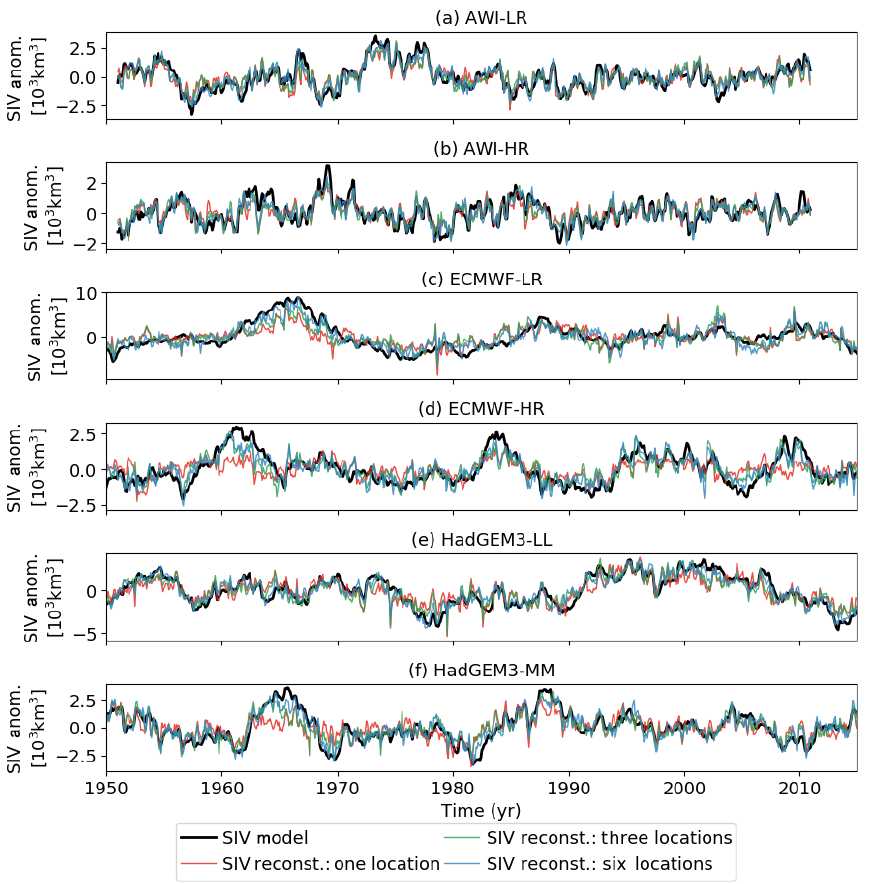
Figure 10. Lag-0 comparison between the original (black) and statistically reconstructed SIV anomalies. The reconstruction takes into account the first (red), the three first (first–third; green), and the six first (first–sixth; blue) optimal locations: (a) AWI-LR, (b) AWI-HR, (c) ECMWF-LR, (d) ECMWF-HR, (e) HadGEM-LL, and (f) HadGEM-MM. Note the different scales on the y